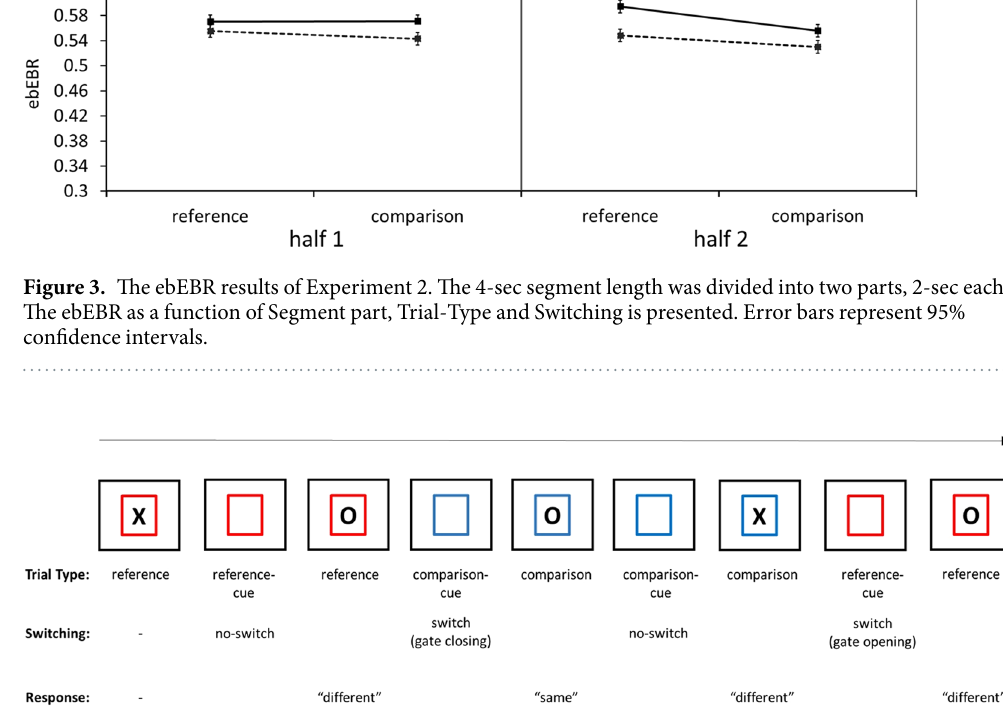
Figure 4. The cued reference-back task. The sequence length of each trial-type was random. The fixation display was presented after the response until 4.5-sec had elapsed from the stimulus presentation. Thus, the inter-trial interval (ITI) varied as a function of the response time. The cue was presented before the stimulus as an empty colored frame for 4-sec. The state of the gate and the correct response for each trial are indicated below each stimulus display.